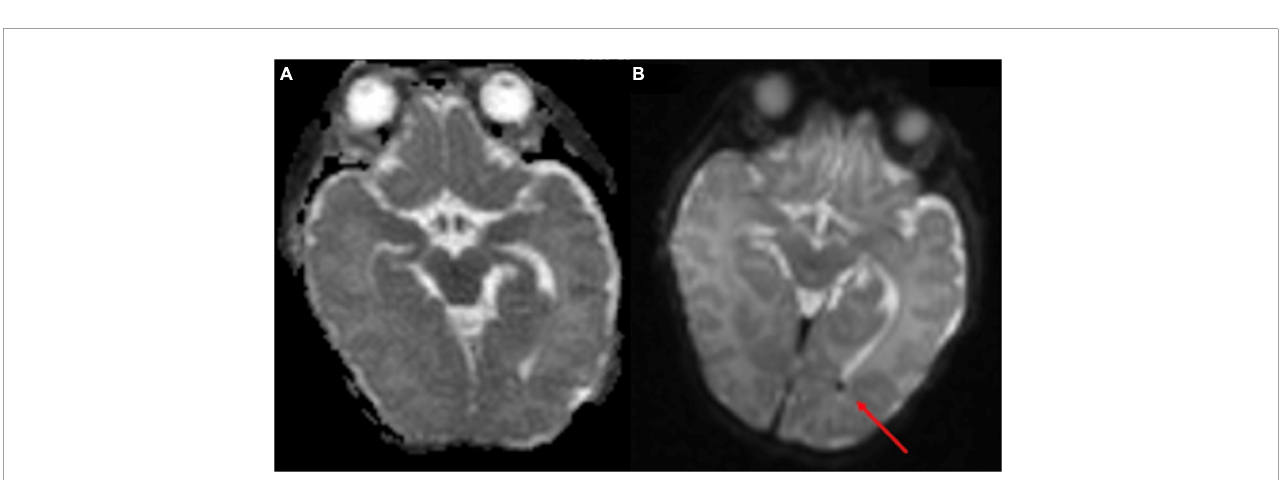
FIGURE6 The point-of-care 1-Tesla routine pre-discharge MRI in a 4-month-old neonate was terminated after obtaining DWI/ADC due to infant movement (A) . Follow-up 3-Tesla MRI 5 days later showed layering IVH in occipital horns, which could be appreciated even on the ADC series (B) . No transcranial ultrasound was